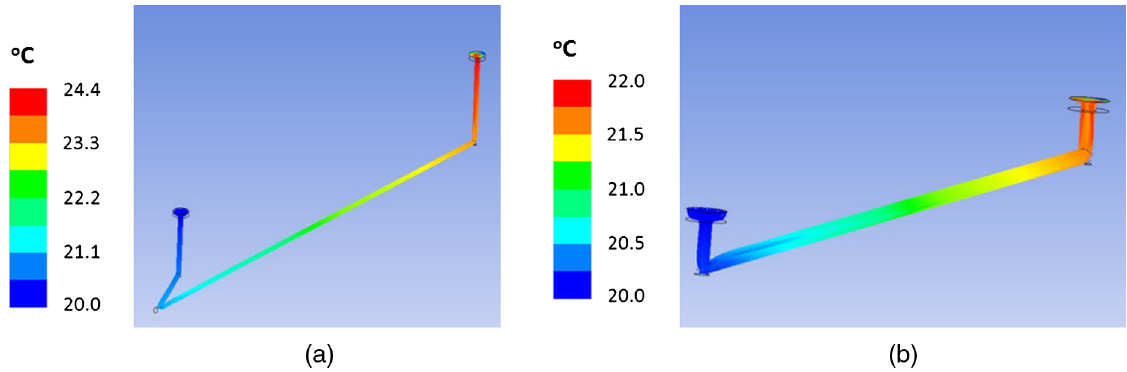
FIG. 15. Results of fluid dynamics simulations showing the water temperature in the cooling